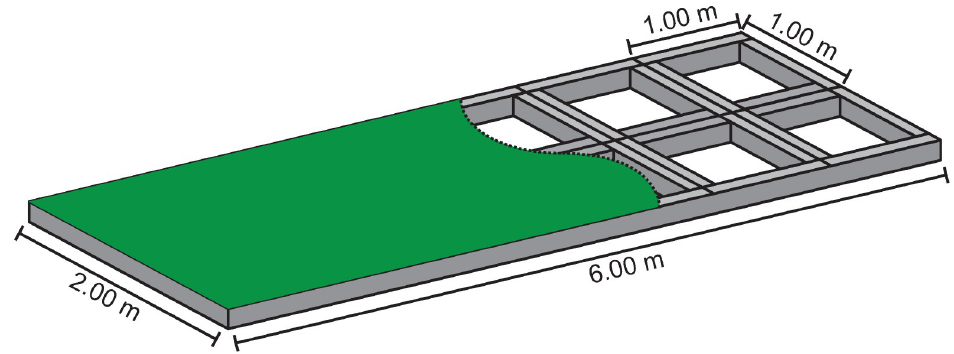
Fig 2. Artificial putting green. Schematic representation of the artificial putting green with substructure of aluminum profiles.